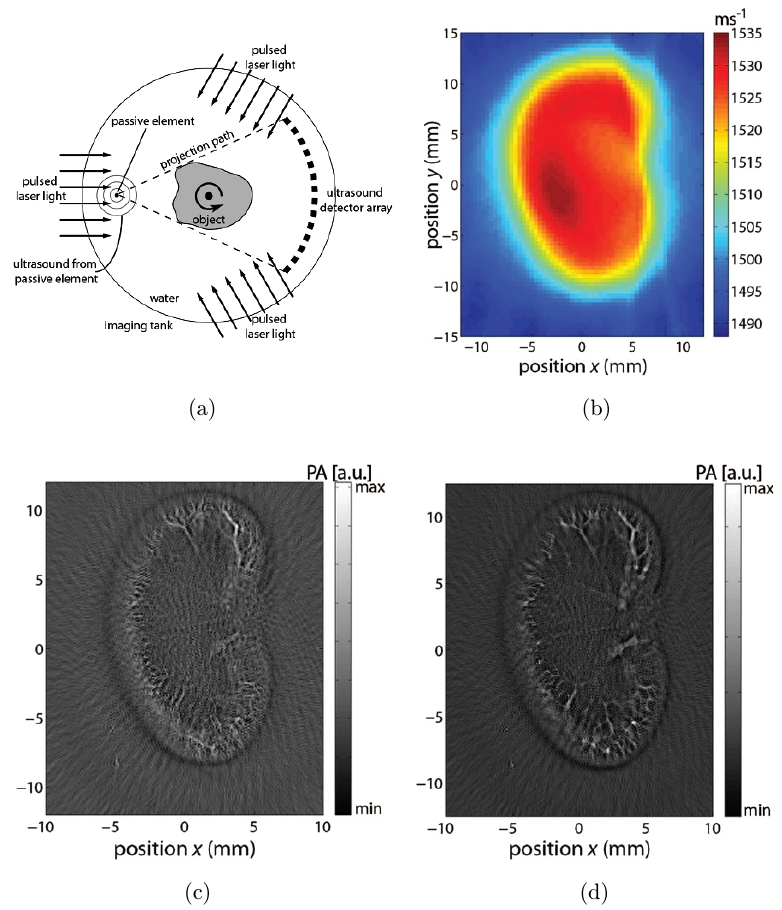
Fig. 10. Passive element enriched PACT. (a) Schematic. (b) SOS map reconstructed from the acquired passive-element mea- surement of the imaging area, (c) PA image reconstructed with a uniform SOS of 1540 m/s, (d) SOS compensated PA image using the SOS values from (a). Reproduced with permission from Ref. 22.